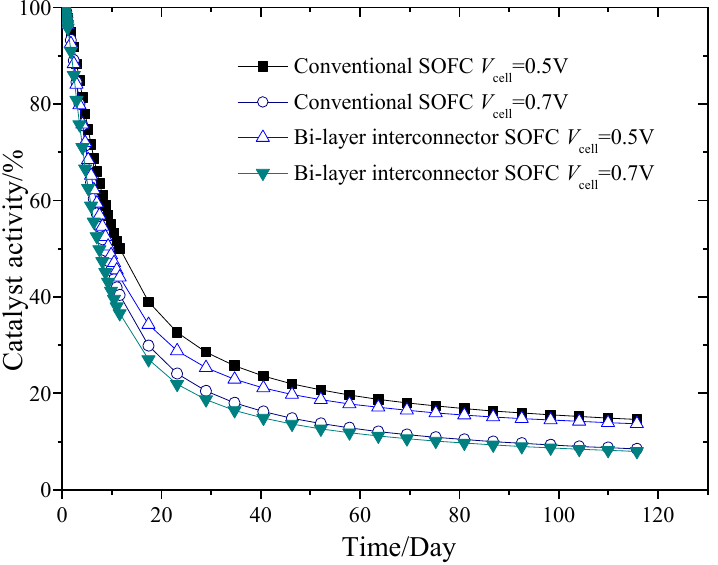
Figure 8. Variation of catalyst activity for SOFC models with different interconnectors.